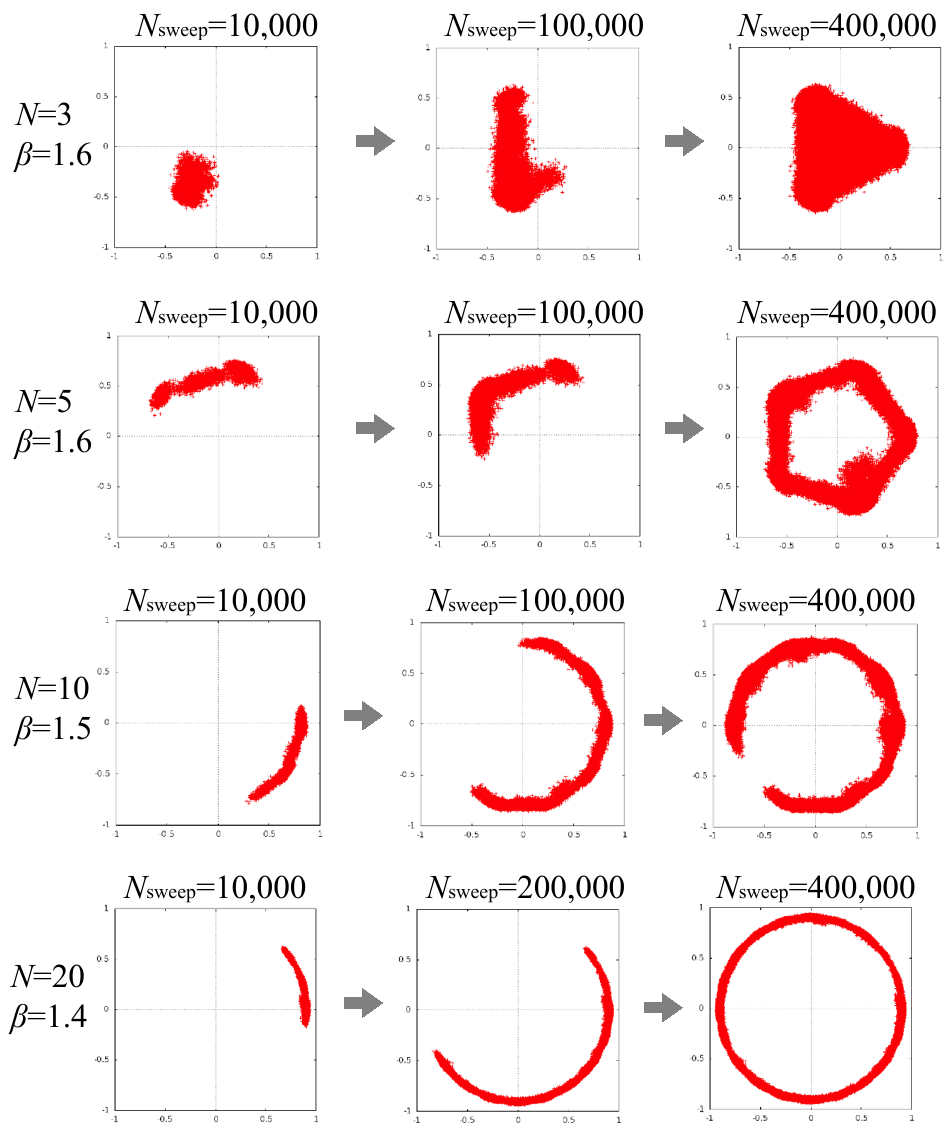
Figure 6 . Distribution plots of the Polyakov loop for N = 3 ; 5 ( (cid:12) = 1 : 6), N = 10 ( (cid:12) = 1 : 5) and N = 20 ( (cid:12) = 1 : 4) with ( N s ; N (cid:28) ) = (200 ; 8) and di(cid:11)erent numbers of samples in the Z N -TBC. Regular N -sided polygon shapes appear as the statistics increases.